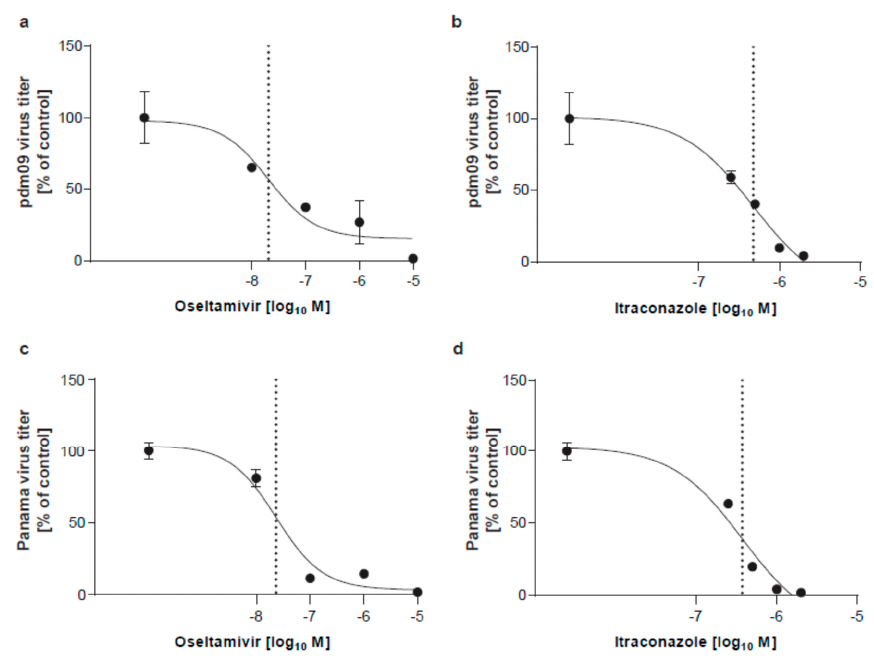
Figure 3. Analysis of the anti-influenza A virus (IAV) activity of oseltamivir and itraconazole. Polarized Calu-3 monolayers were infected with 0.1 MOI of ( a , b ) IAV H1N1pdm09 (pdm09) or ( c , d ) A / Panama / 2007 / 99 (Panama) for 24 h. At 2 h p.i. cells were treated with oseltamivir ( a , c ) or itraconazole ( b , d ) at the indicated concentrations for 16 h. Data represent mean percentages of viral titers ± SEM, with mean virus titer in control cells (treated with the solvent DMSO) set to 100%; n = 3. LogIC 50 values were determined by fitting a non-linear regression model. Viruses 2020 , 12 , 703